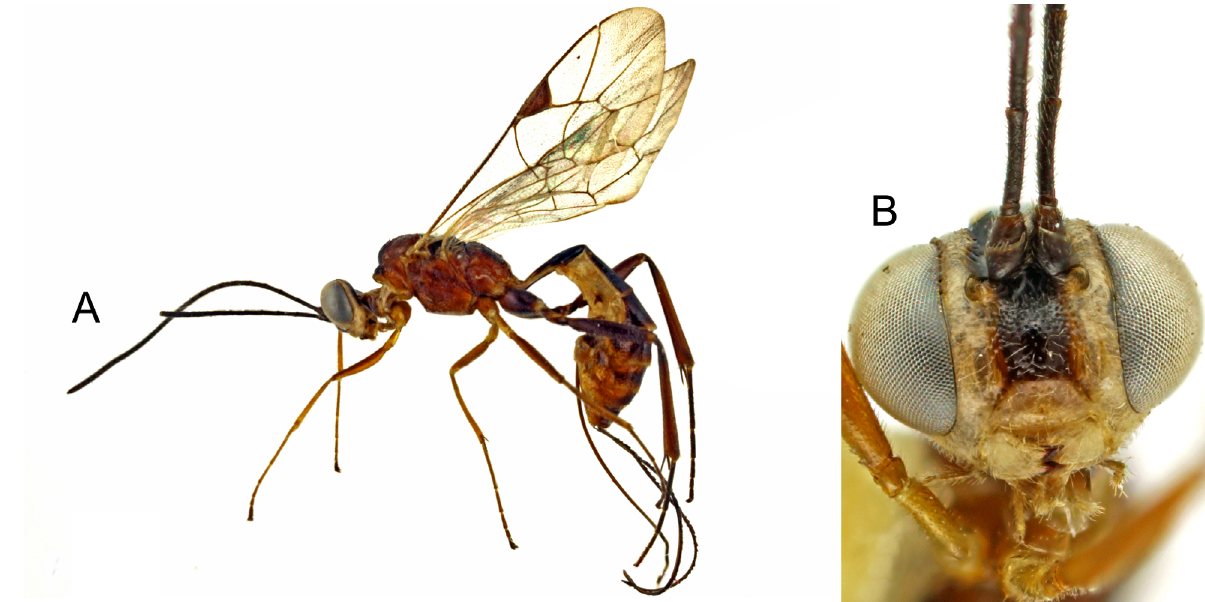
Fig. 13. Pristomerus ranomafana sp. nov. A . ♀, habitus, profile. B . ♀, head,